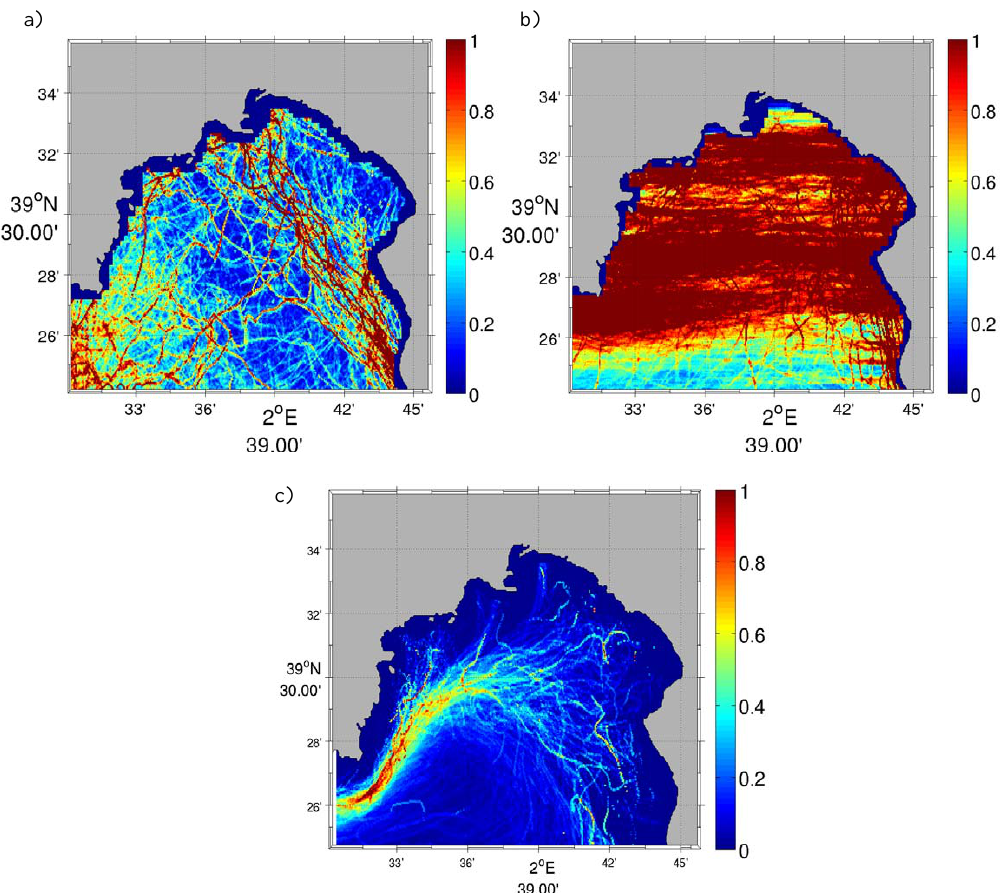
Fig. 4. Spatial distribution of the time average of 6-hourly FSLEs maps over different months and at different layers: (a) October at surface layer, (b) July at surface layer, (c) July at bottom